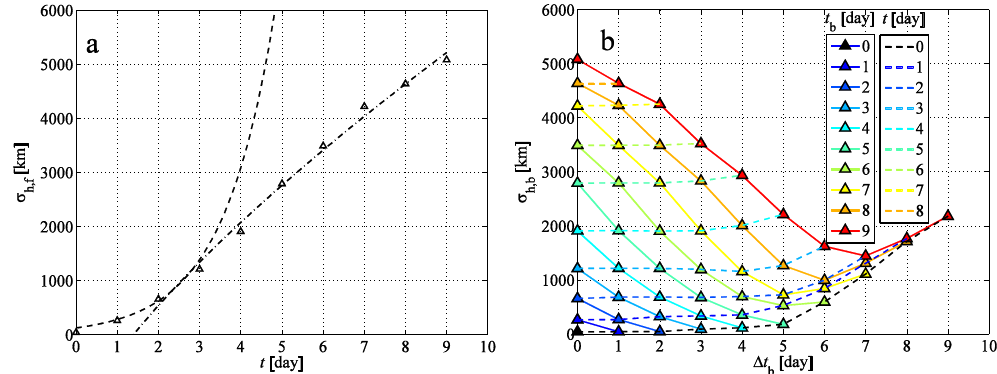
Figure 4. ( a ) The horizontal standard deviation σ h,f of the forward cloud (FWC) in Figure 3 as a function of time t with an exponential fit over t = 0–2 days (dashed line) and a power-law fit over t = 2–9 days (dash-dotted line); ( b ) the horizontal standard deviation σ h,b of the backward clouds (BWCs) in Figure 3 as a function of the time interval of the backward simulation ∆ t b = t b − t . Solid lines represent the time evolution of the BWCs initiated at t b (see color legend) backward in time; dashed lines connect the values corresponding to time t